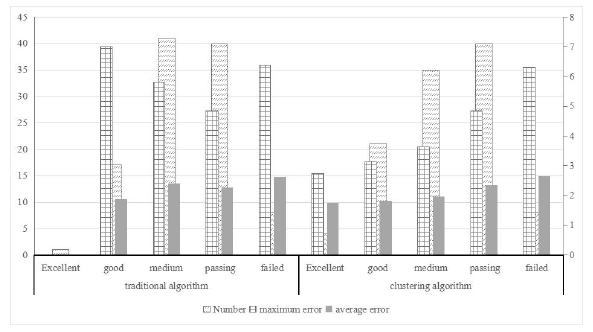
Fig. 5. Classification results of two